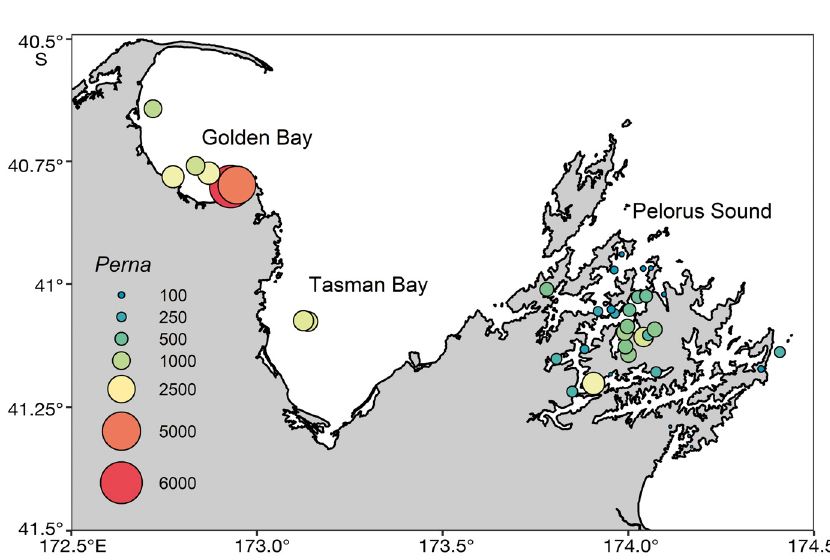
outliersFig. 3. Historical (1993−2018) average green-lipped mussel Perna canaliculus spat settlement (ind. m −1 wk −1 ) aggregated across depths, months and